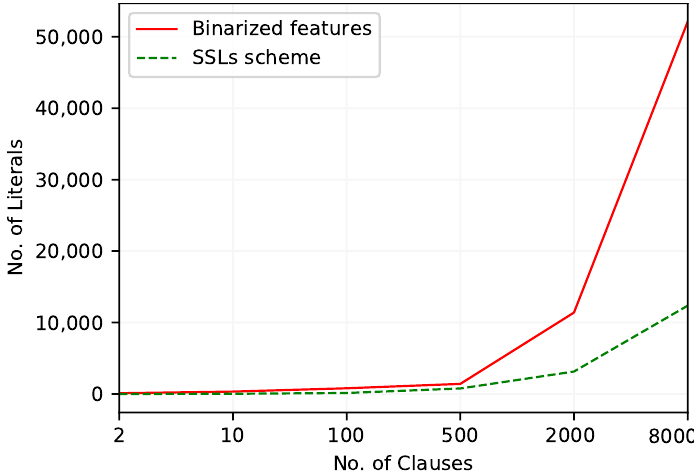
Figure 7. The number of literals included in TM clauses to work with Heart Disease dataset.